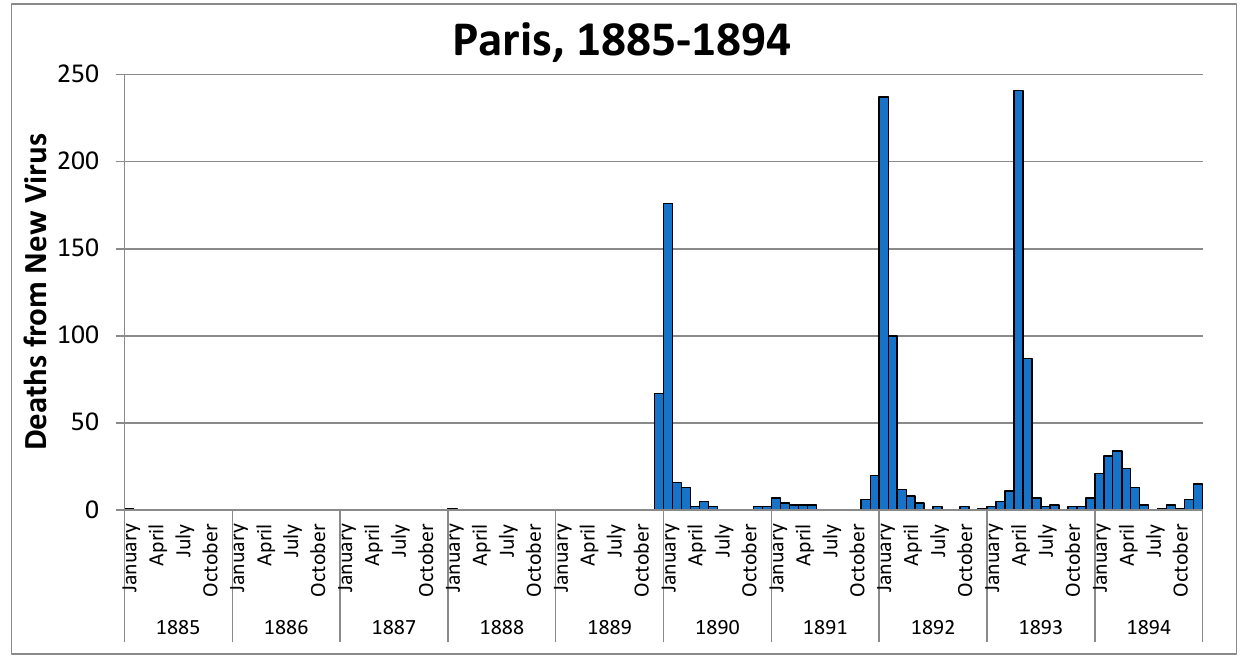
Figure 1. Deaths from the new virus, diagnosed as ‘grippe’, in Paris from 1885 to 1894. Source: “Annuaire statistique de la ville de Paris” [15].